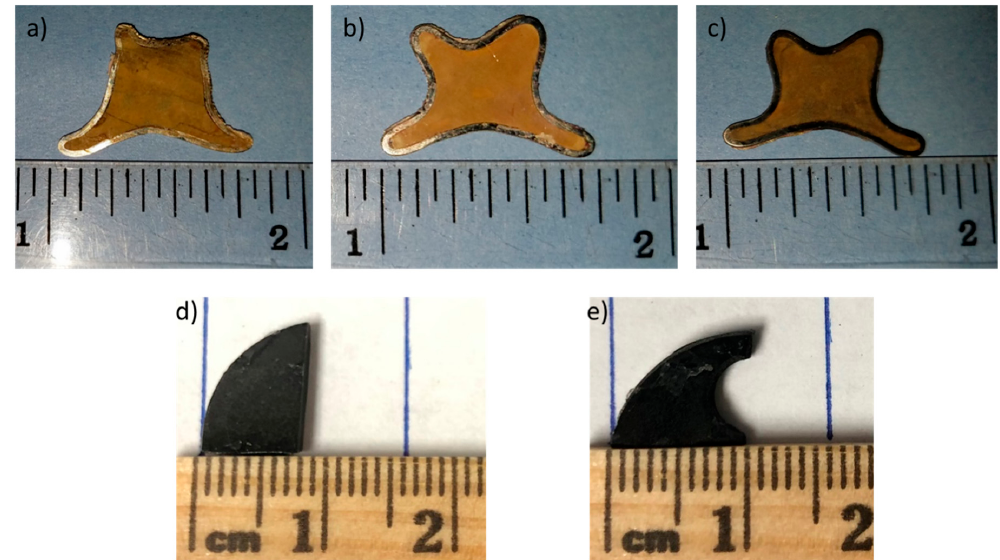
Figure 1. Photographs showing the samples used in this study: ( a ) AgZ 1-3; ( b ) AgZ 1-7; ( c ) AgZ 1-8; ( d ) SPS-1; and ( e ) SPS-2. Table 1. Composition of the AgZ samples used in this study determined using the average area scan from multiple EDS maps. The standard deviation is representative of the multiple areas imaged to determine the average composition.